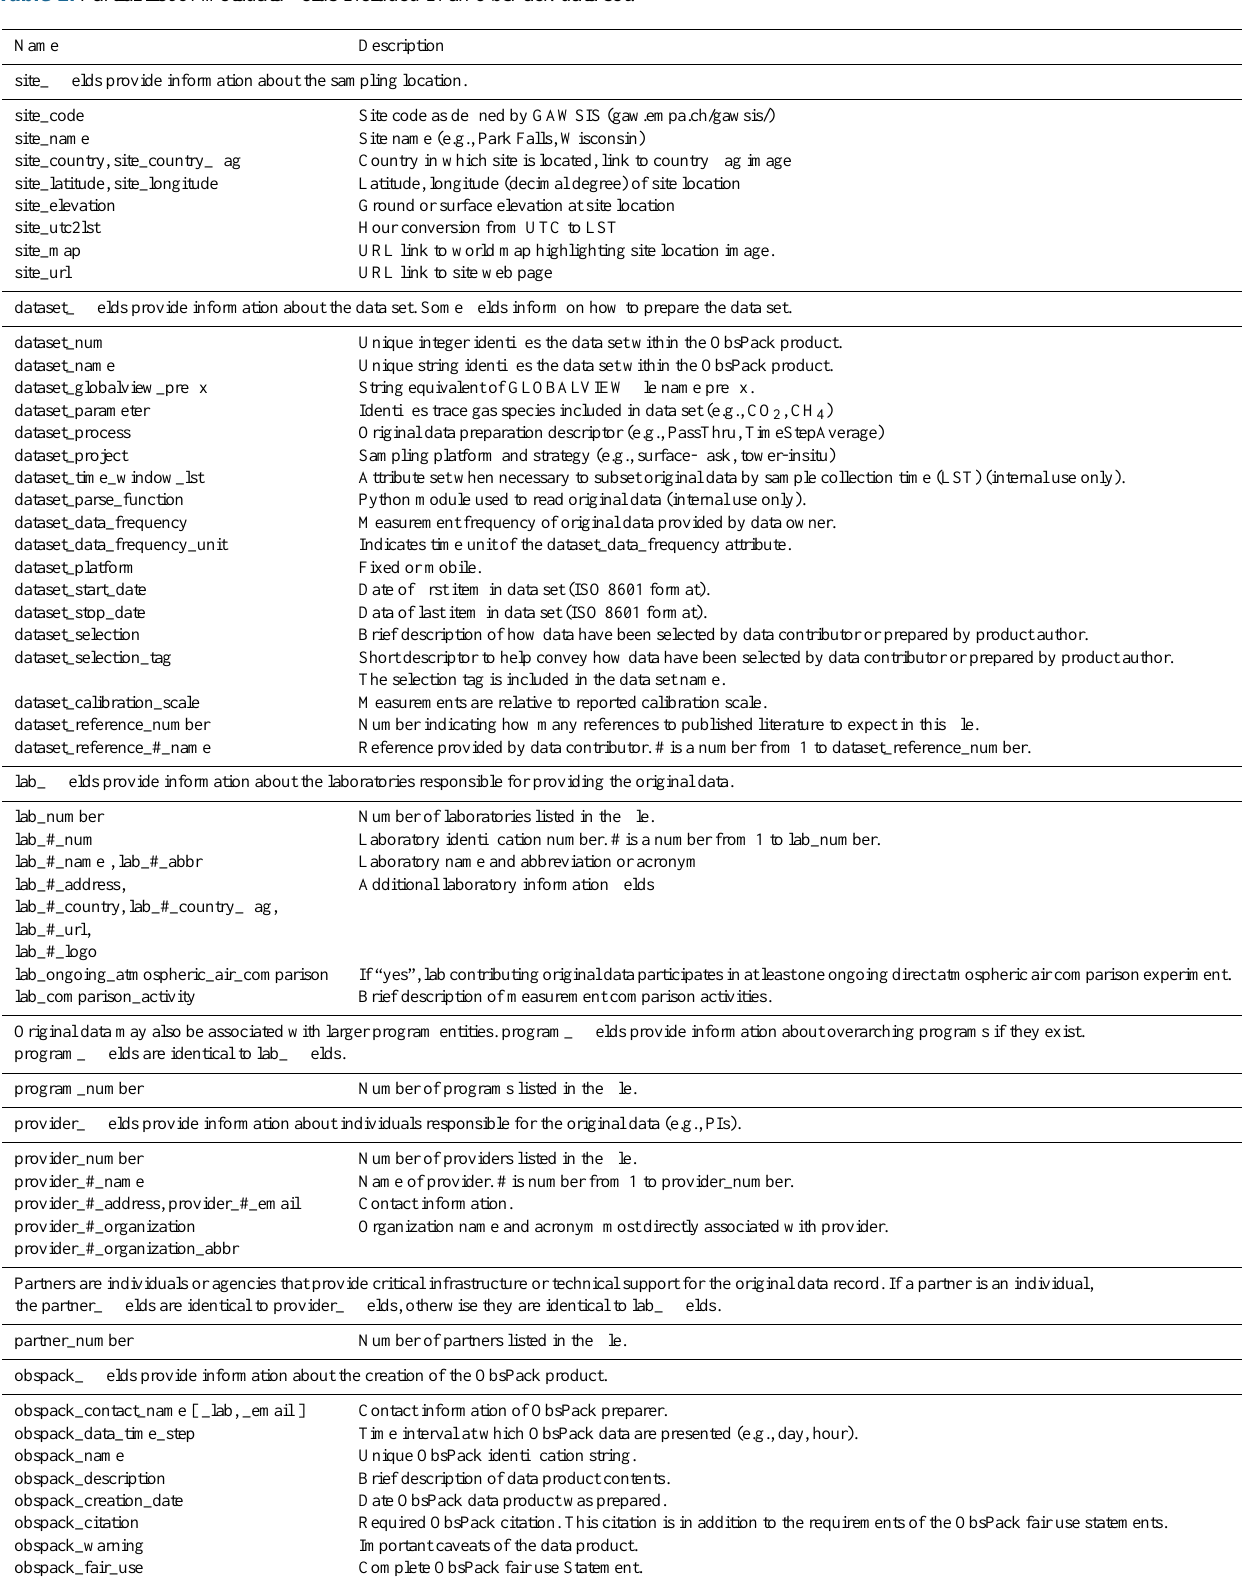
Table 2. Partial list of metadata fields included in an ObsPack data